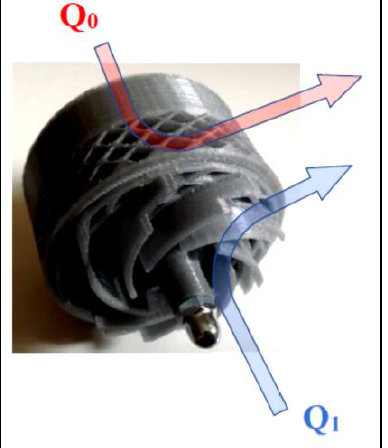
Figure 31. Rotor micromodel for a turbo-pump with radial mesh turbine.